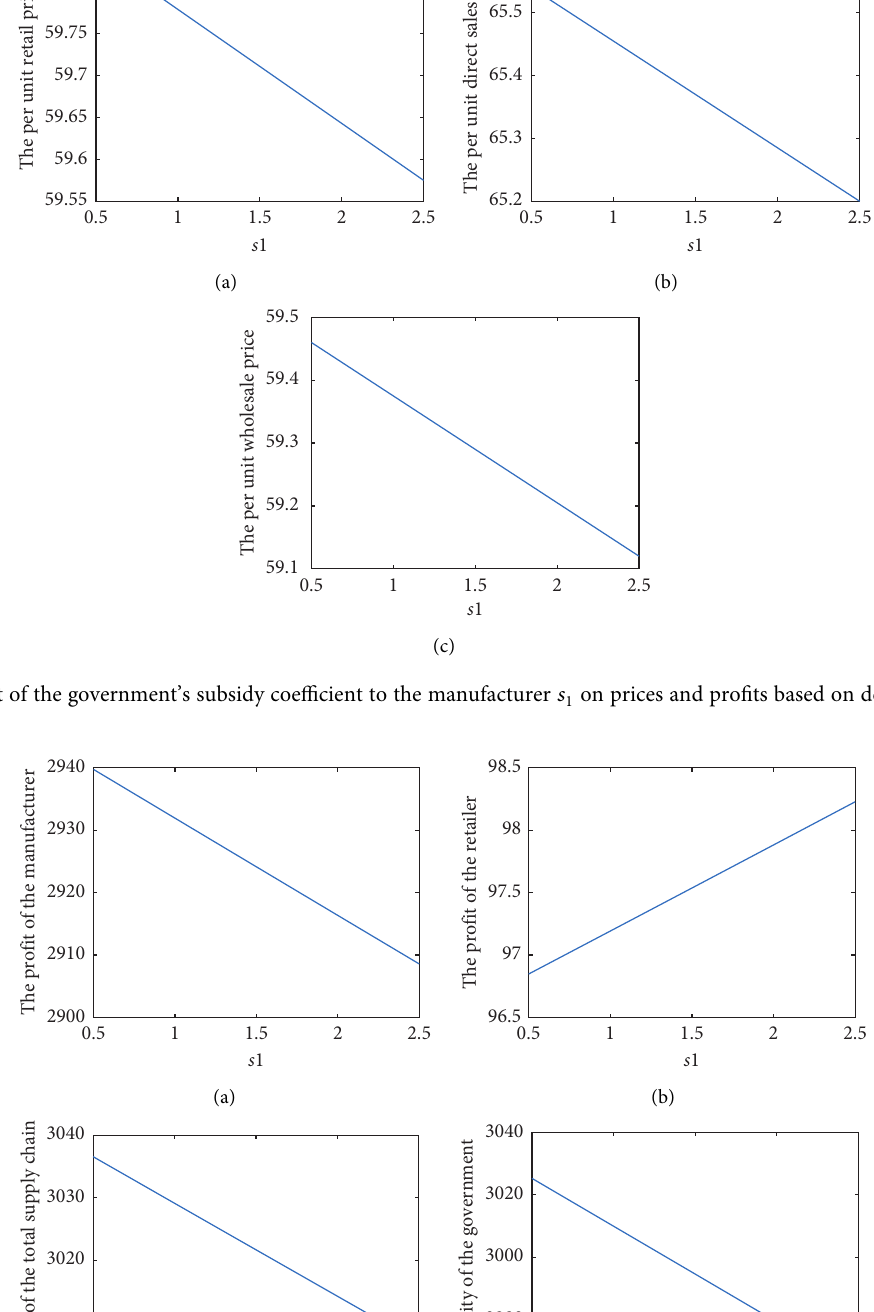
on profits based on decentralized 1